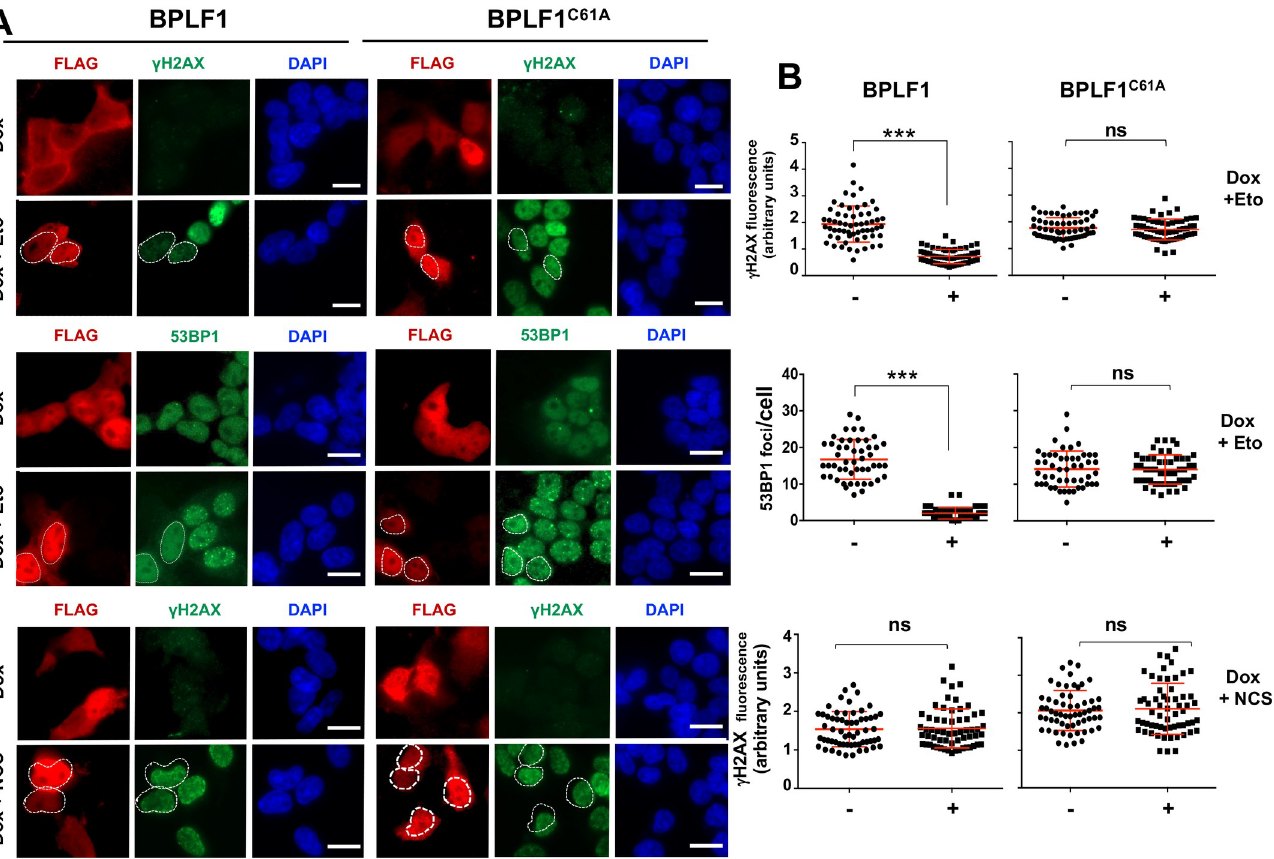
Fig 3. BPLF1 selectively inhibits the detection of TOP2-induced DNA damage. HEK-rtTA-BPLF1/BPLF1 C61A cells grown on cover-slides were treated with 1.5 μ g/ml Dox for 24 h to induce the expression of BPLF1 followed by treatment for 1 h with 40 μ M Etoposide or 0.5 μ g/ml of the radiomimetic Neocarzinostatin (NCS) before staining with the indicated antibodies. ( A ) The cells were co-stained with antibodies against FLAG (red) and antibodies to γ H2AX or 53BP1 (green) and the nuclei were stained with DAPI (blue). The expression of catalytically active BPLF1 was associated with a significant decrease of Etoposide induced nuclear γ H2AX fluorescence and decreased formation of 53BP1 foci. BPLF1 C61A had no effect. Neither the catalytically active nor the inactive BPLF1 affected the induction of γ H2AX in cells treated with NCS. Representative micrographs from one of two experiments where all conditions were tested in parallel are shown. Scale bar = 10 μ m. (B) Quantification of γ H2AX fluorescence intensity and number of 53BP1 foci in BPLF1/BPLF1 C61A positive and negative cells from the same images. The Mean ± SD of fluorescence intensity or number of dots in at least 50 BPLF1-positive and 50 BPLF1-negative cells recorded in each condition is shown. Statistical analysis was performed using Student’s t-test. ��� P � 0.001; ns, not significant.